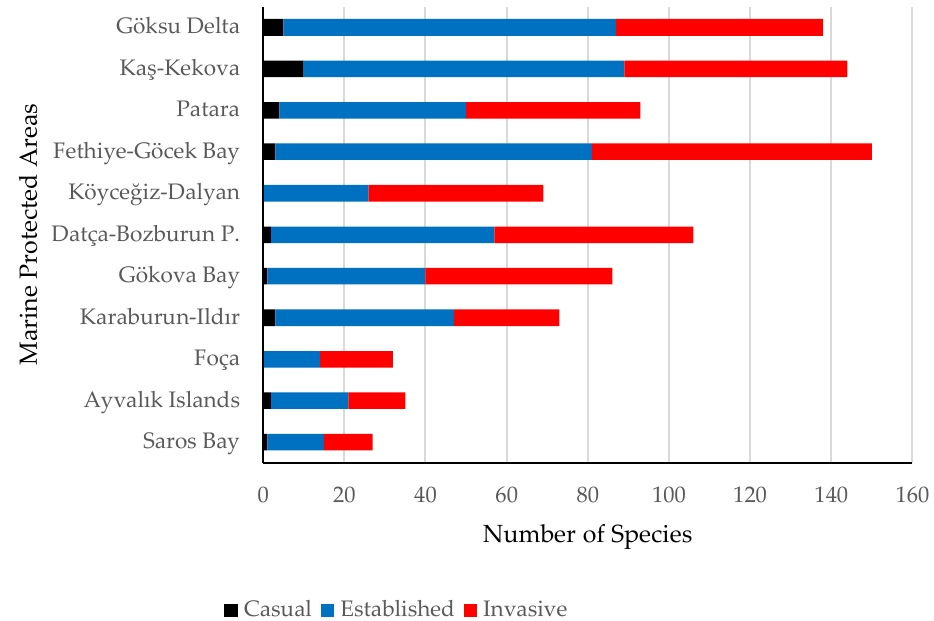
Figure 3. Establishment success of alien taxa in MPAs.